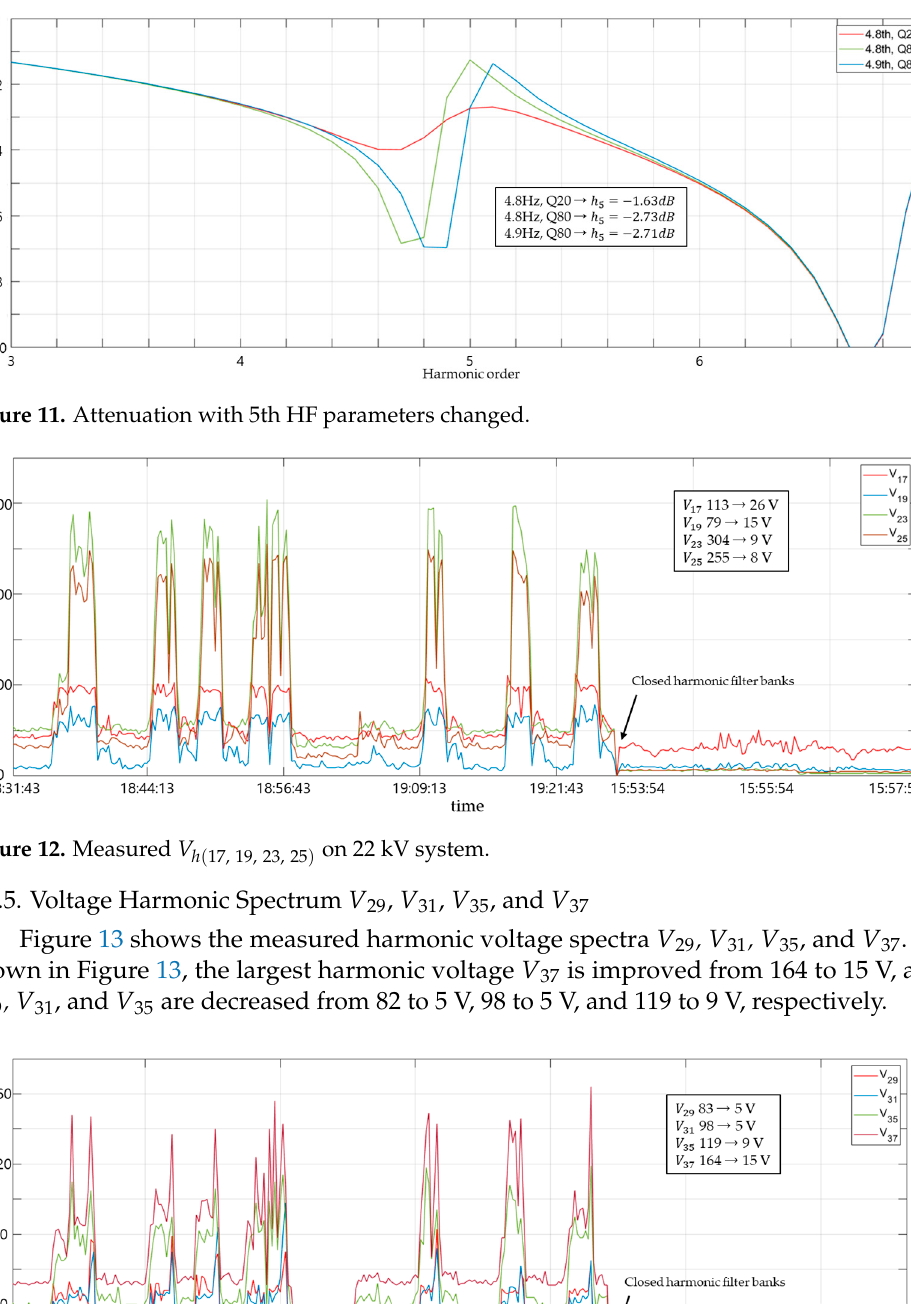
Figure 10. Measured 𝑉 (cid:3035)((cid:2873),(cid:2875),(cid:2869)(cid:2869),(cid:2869)(cid:2871)) for 22 kV system.